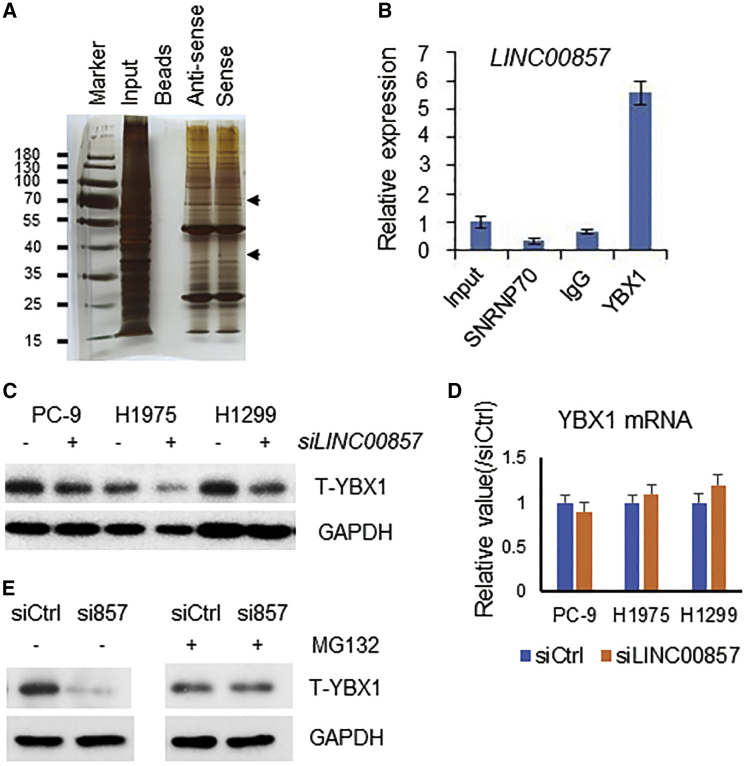
LINC00857 Interacts with the YBX1 Protein(A) Silver staining of SDS-PAGE showing LINC00857-interacting proteins from LINC00857 RNA pull-down assay. The different protein bands between the antisense group and sense group were indicated with arrows. They were submitted for mass spectrometry (MS) analysis. An extra band between 35 and 40 kD in LINC00857 binding proteins was identified as YBX1 by MS. (B) Real-time PCR confirmed that LINC00857 was accumulated in the YBX1-precipitated protein sample using the RIP assay in H1299 cell. (C) The YBX1 protein level was decreased after LINC00857 knockdown with siRNA. (D) Real time PCR showing YBX1 mRNAs was not changed after LINC00857 knockdown by siRNA as compared to control at 48 h. (E) LINC00857 prevented YBX1 protein from proteasome degradation in PC-9 cells.